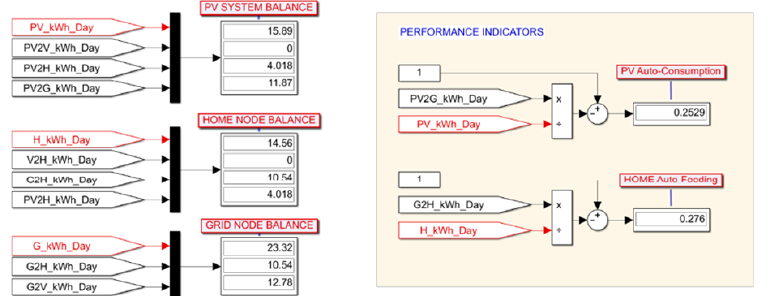
Figure 11. Winter week. Base Case results.